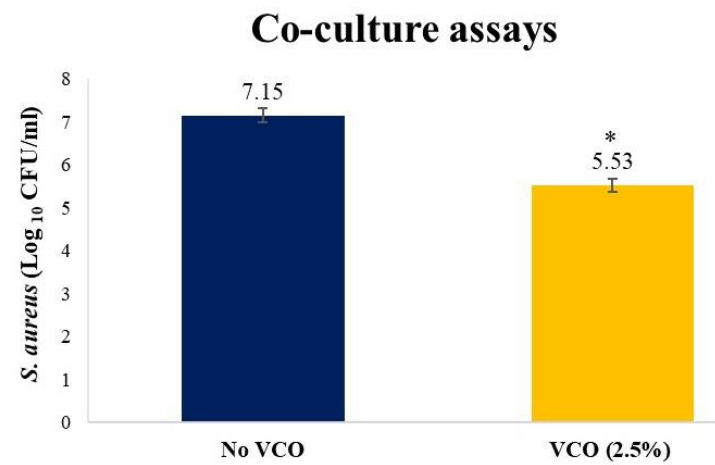
Figure 2: Effect of fermented VCO in rich medium on suppression of S. aureus , under the co-cultured condition of S. epidermidis and S. aureus. Overnight cultures of S. aureus on the selective agar plates were counted (A) and exhibited in Log 10 CFU/ml (B). The number of S. aureus in co-culture consisting of VCO (2.5% v/v) decreased compared with the VCO absent medium. Data are the mean ± SD. Statistical analysis were evaluated by an independent t-test, and p value < 0.05(*) showed